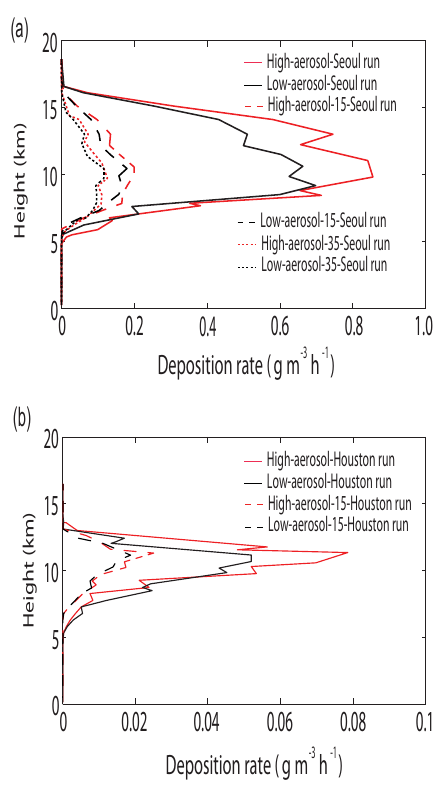
Figure 9. Same as Fig. 8, but for deposition rates.